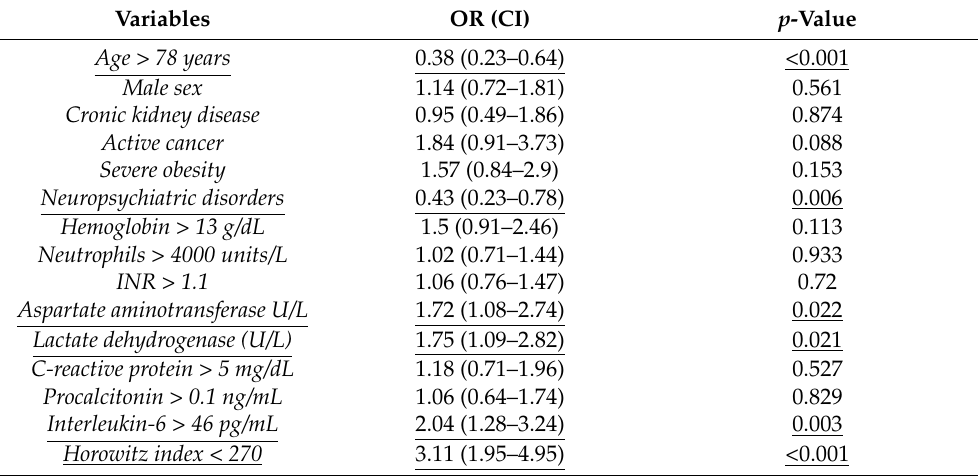
Table 2. Multivariate analysis of the factors associated with increased risk for need of hCPAP.